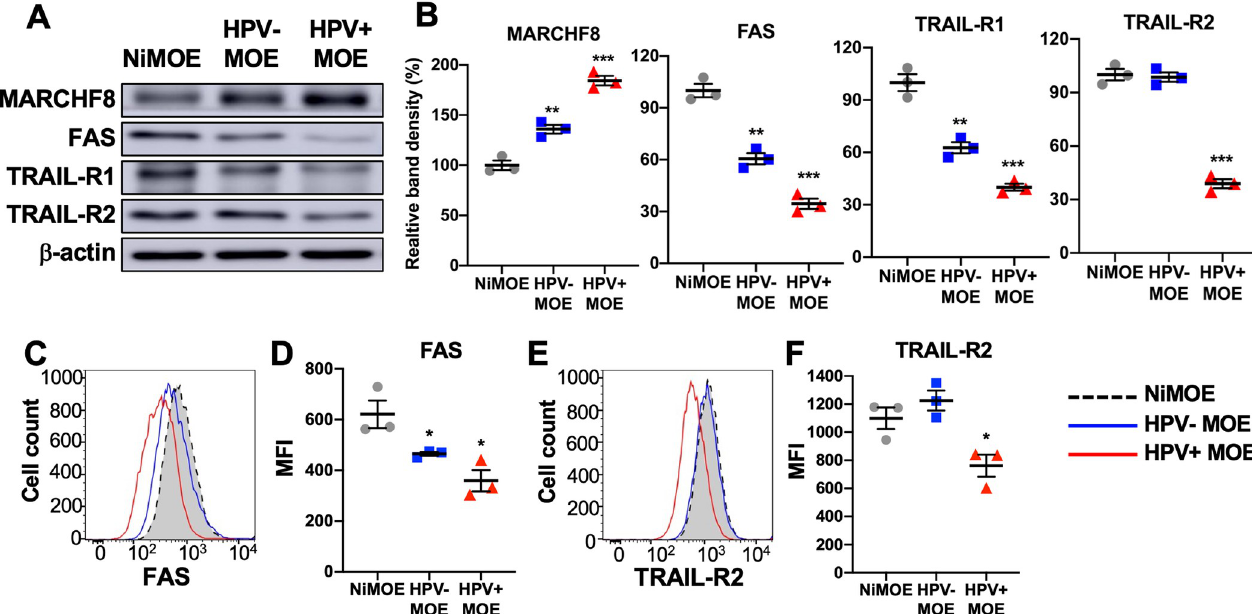
Fig 7. MARCHF8 is upregulated, and death receptor expression is downregulated in HPV+ mouse oral cancer cells. Mouse MARCHF8, FAS, TRAIL-R1, and TRAIL-R2 protein levels in mouse normal immortalized (NiMOE), HPV- transformed (HPV- MOE), and HPV+ transformed (HPV+ MOE) oral epithelial cells were determined by western blotting ( A ). β -actin was used as a loading control. The relative band density was quantified using NIH ImageJ ( B ). Cell surface expression of FAS ( C and D ) and TRAIL-R2 ( E and F ) proteins on NiMOE (dotted black line), HPV- MOE (blue line), and HPV+ MOE (red line) cells were analyzed by flow cytometry. Mean fluorescence intensities (MFI) of three independent experiments are shown ( D and F ). All experiments were repeated at least three times, and the data shown are means ± SD. P values were determined by Student’s t -test. � p < 0.05, ��� p <